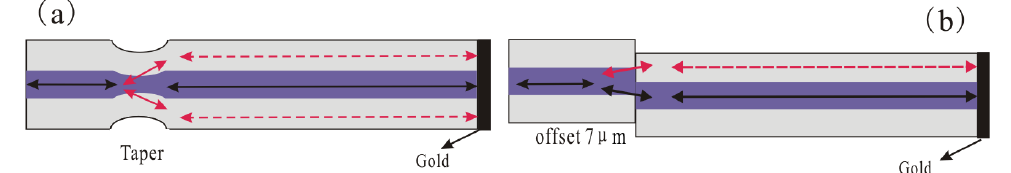
Figure 14. The RI sensitivity of two in-line MIs based on: ( a ) the fiber taper; ( b ) the core-offset structure,